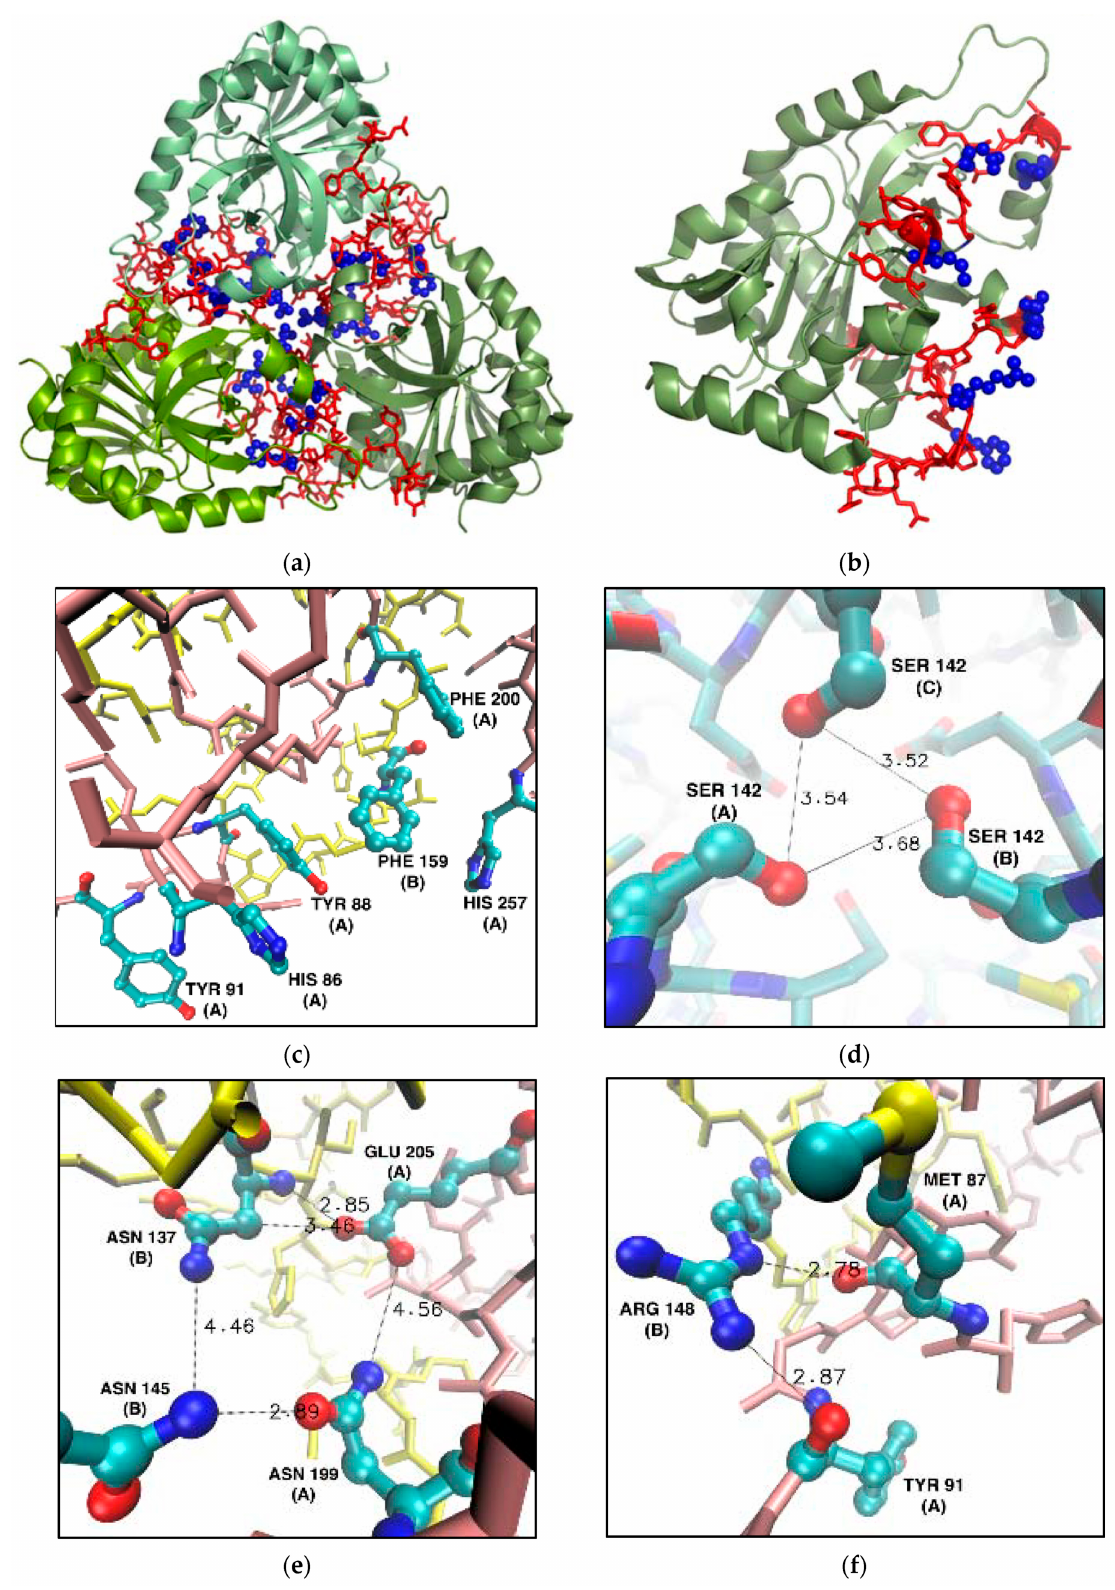
Figure 6. Residues selected for mutation into alanine in the WT calf PNP (PDB ID 3FUC [27]). Non- mutated amino acids belonging to the monomer–monomer interface (red) and six mutated (blue) residues localized on the interface shown in the overall structure of the calf PNP trimer ( a ) and